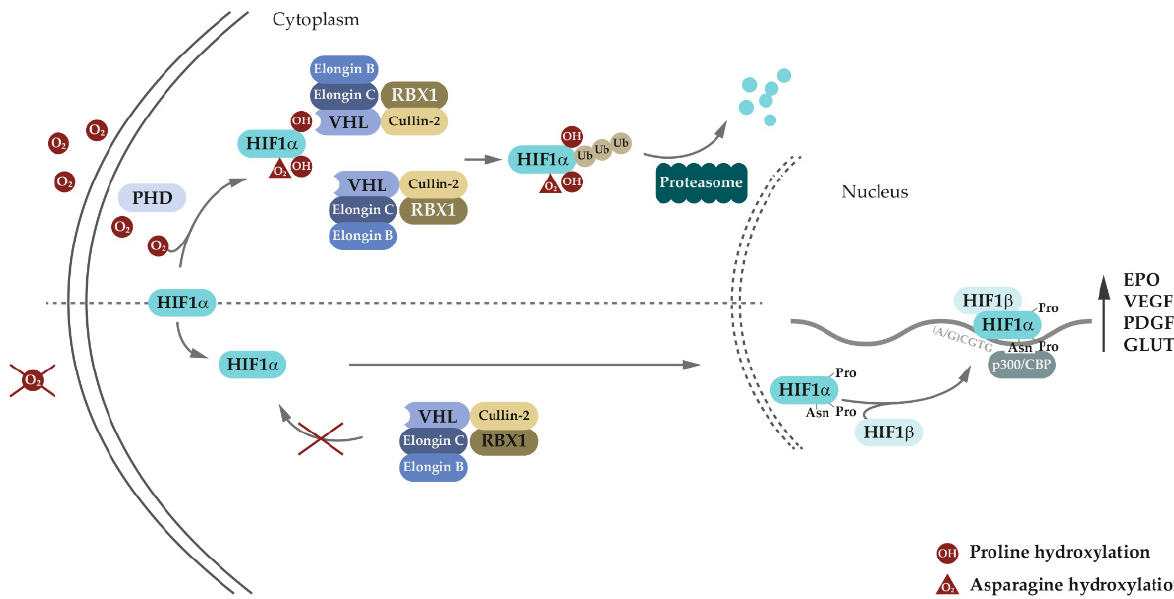
Figure 2. Role of VHL in adaptive response to oxygen levels.